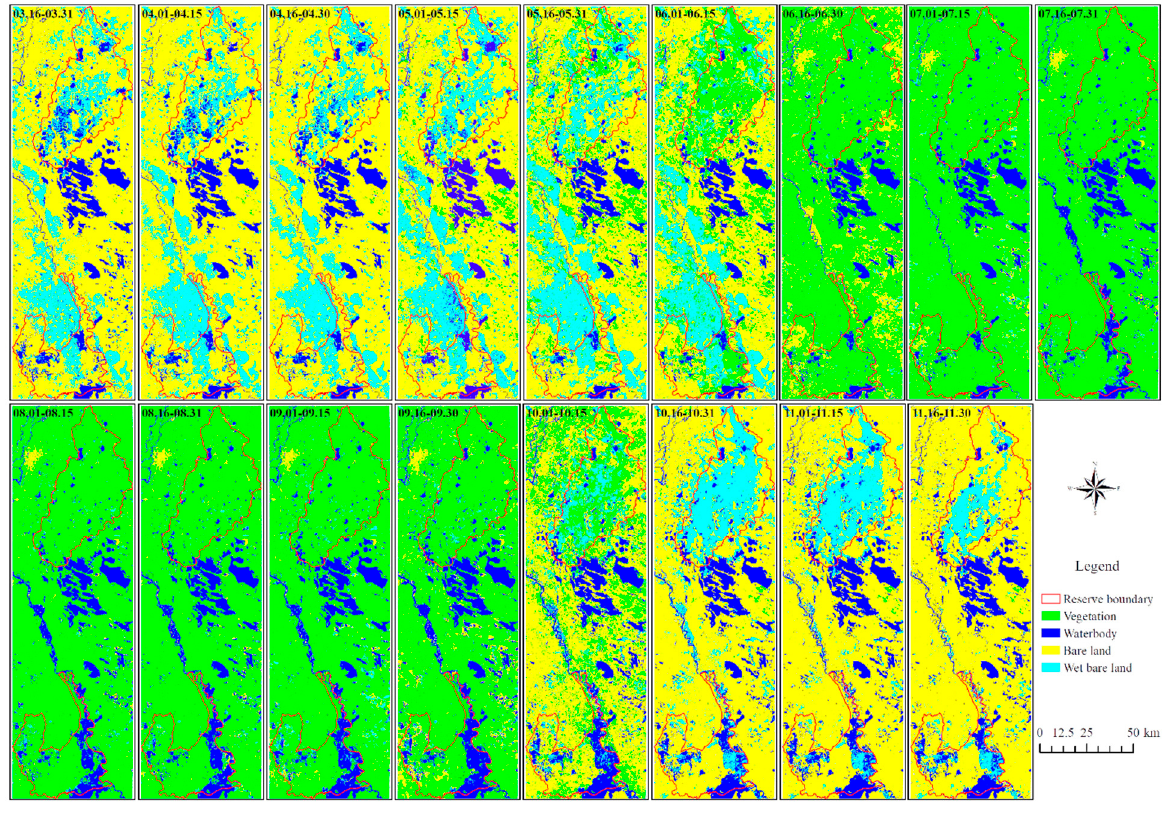
Figure 7. Intra-annual classification results based on 15-day periods.